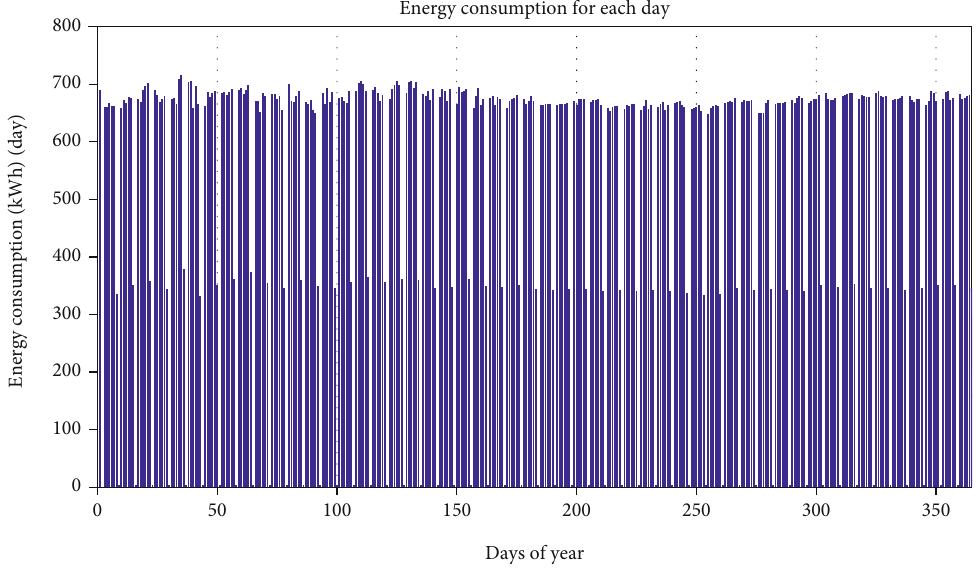
Figure 7: EnergyPlus daily energy consumption in the block for a